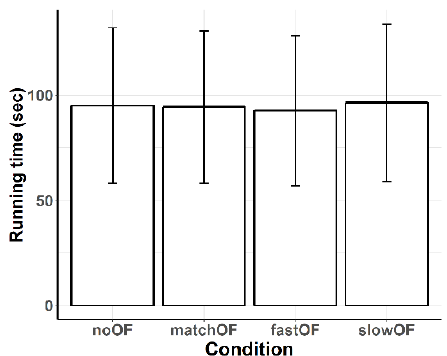
Figure 3. Task duration. Time needed for the participants to retrieve the running speed they perceived as matching the previously experienced reference running speed. The bars represent the means and the error bars the 95% confidence interval of those means.